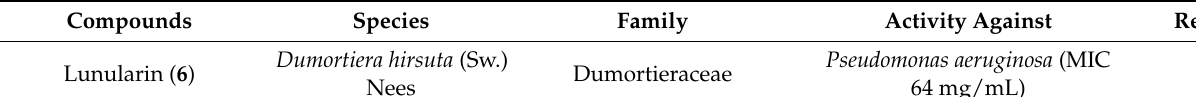
Table 4. Antimicrobial activities of compounds isolated from bryophytes.